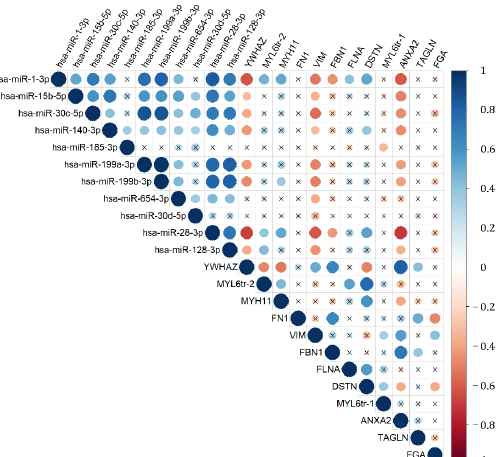
Figure 4. Correlation matrix based on the analysis of the miRNAs and gene target expression levels in the IUGR > 34, SGA > 34, PE > 34, and N > 34 groups obtained while using nonparametric Spearman rank correlation method. Positive and negative correlations are indicated in blue and in red, respectively. In the case of significant ( p < 0.05) values, correlations are indicated by a dot; in the case of nonsignificant values, correlations are indicated by a cross.